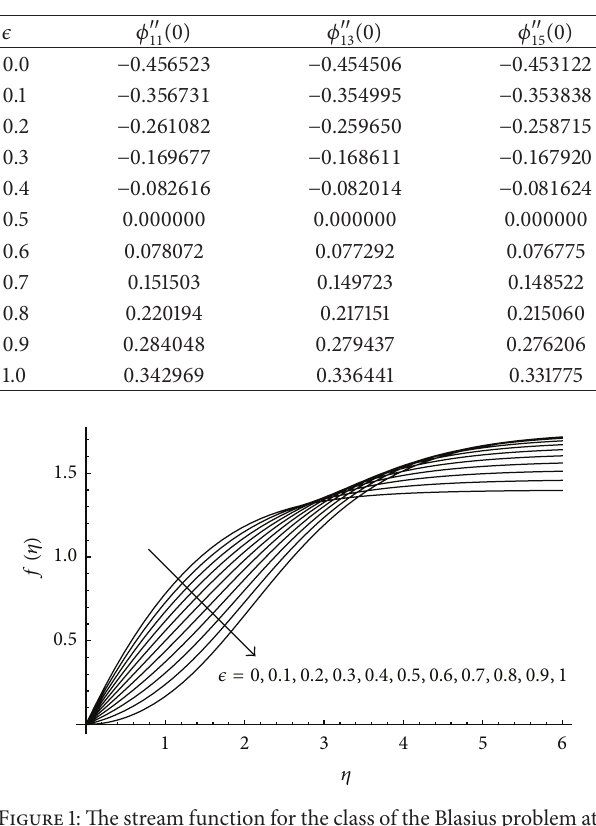
Table 1: The approximate values of the skin-friction coefficient 𝑓 󸀠󸀠 (0) for the class of the Blasius problem using 11, 13, and 15 terms of Adomian’s series.